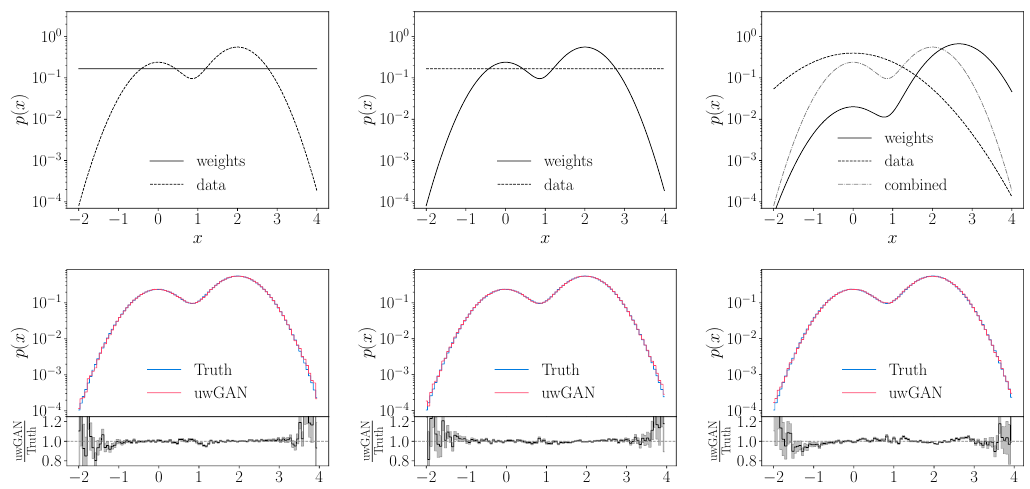
Figure 1: Event vs weight distribution of the training data (top) and GANned vs truth kinematic distributions (bottom) for unweighted events (left), uniform distribution (center), and our hybrid case (right). The lower panels in the bottom show the bin- wise truth-to-GAN